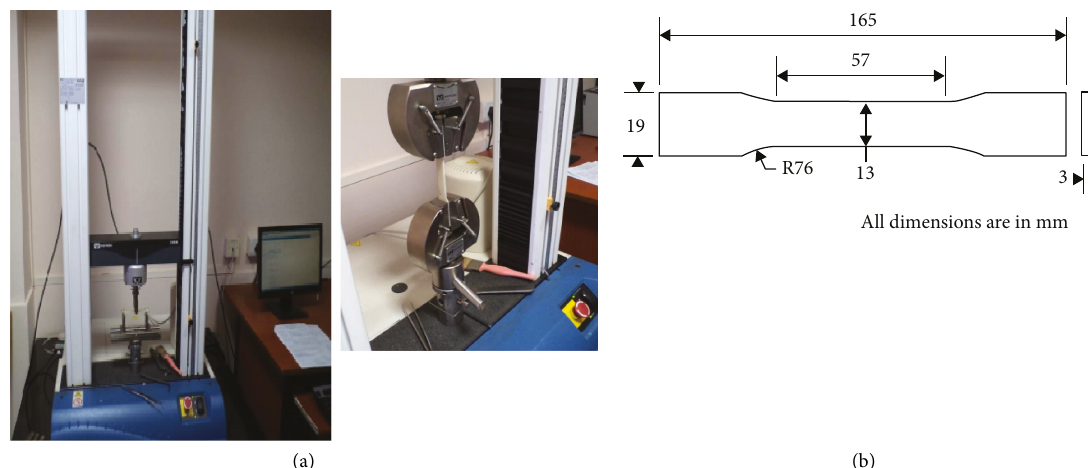
Figure 3: (a) UTM test setup. (b) Specimen dimensions as per ASTM D 638.